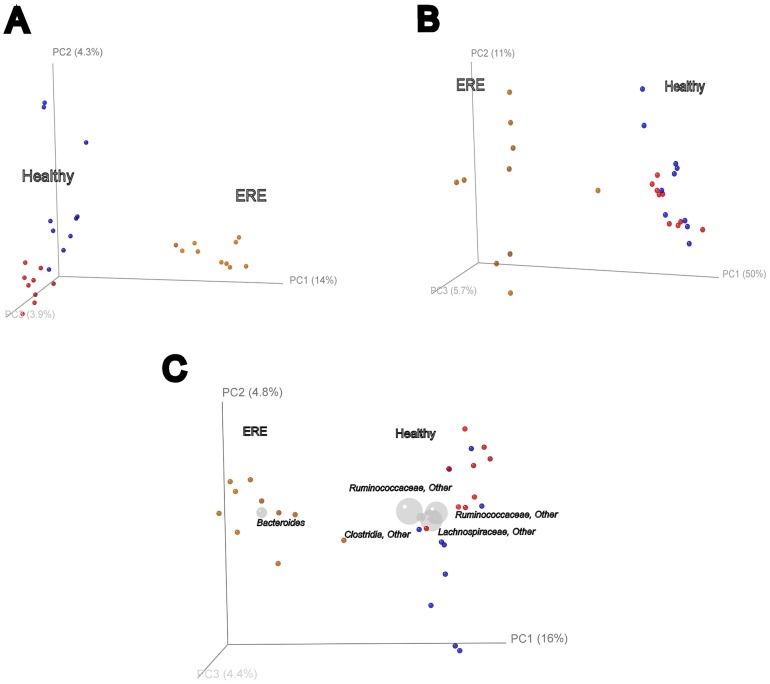
Principal Coordinates Analysis (PCoA) 3D plots generated with UniFrac showing clustering of OTUs bacterial groups of cecal samples from ERE, and Healthy (Control and Antibiotic) groups.PCoA is a Multidimensional Scaling Method that allows to explore and to visualize dissimilarities of phylogenetic data from a distance matrix imported from RDP, assigning a location to each sample in a 3D graphics. Panel A, unweighted plot; panel B, weighted plot (taking into account the relative abundance of each taxon in the samples); panel C, Biplot representation of PCoA of unweighted, pairwise Unifrac distances showing clustering of bacterial groups cecal samples from ERE, Control and Antibiotic groups. Blue spheres are Control rabbits, red spheres are the Antibiotic group and light brown spheres are the ERE rabbits. In panel C, the Biplot shows the projection of taxa positions (grey spheres) that represent weighted averages of the coordinates of all samples. The size of the spheres is proportional to the relative abundance of the taxon.